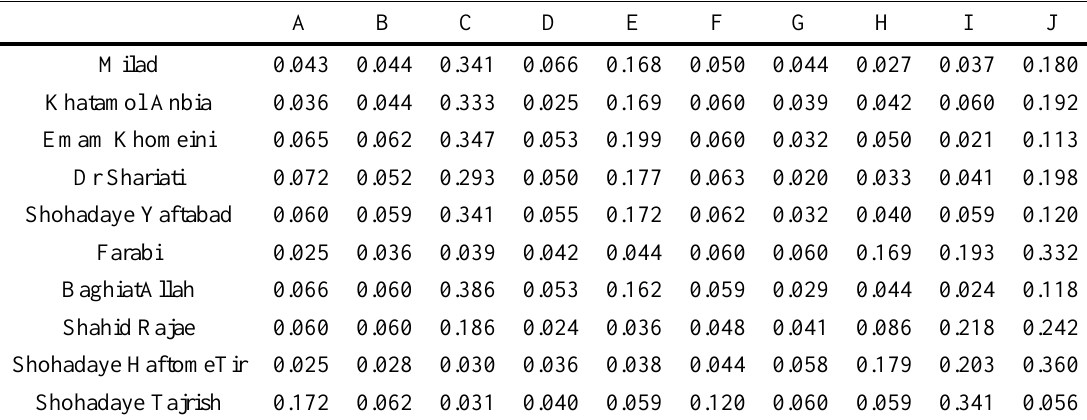
Table 4. Weights of each hospital's indicators.